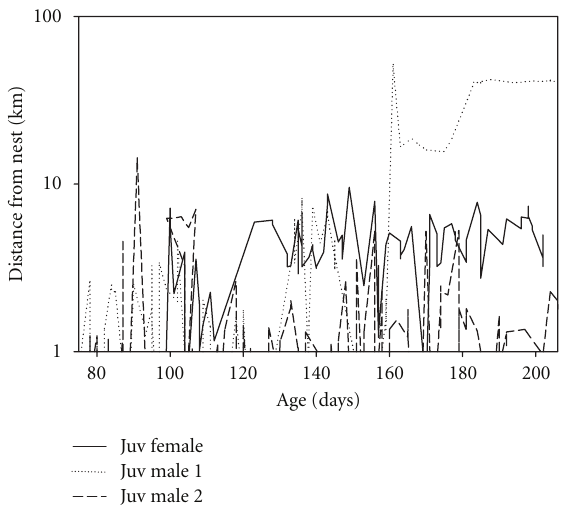
Figure 2: Distance from nest over time for juvenile falcons.